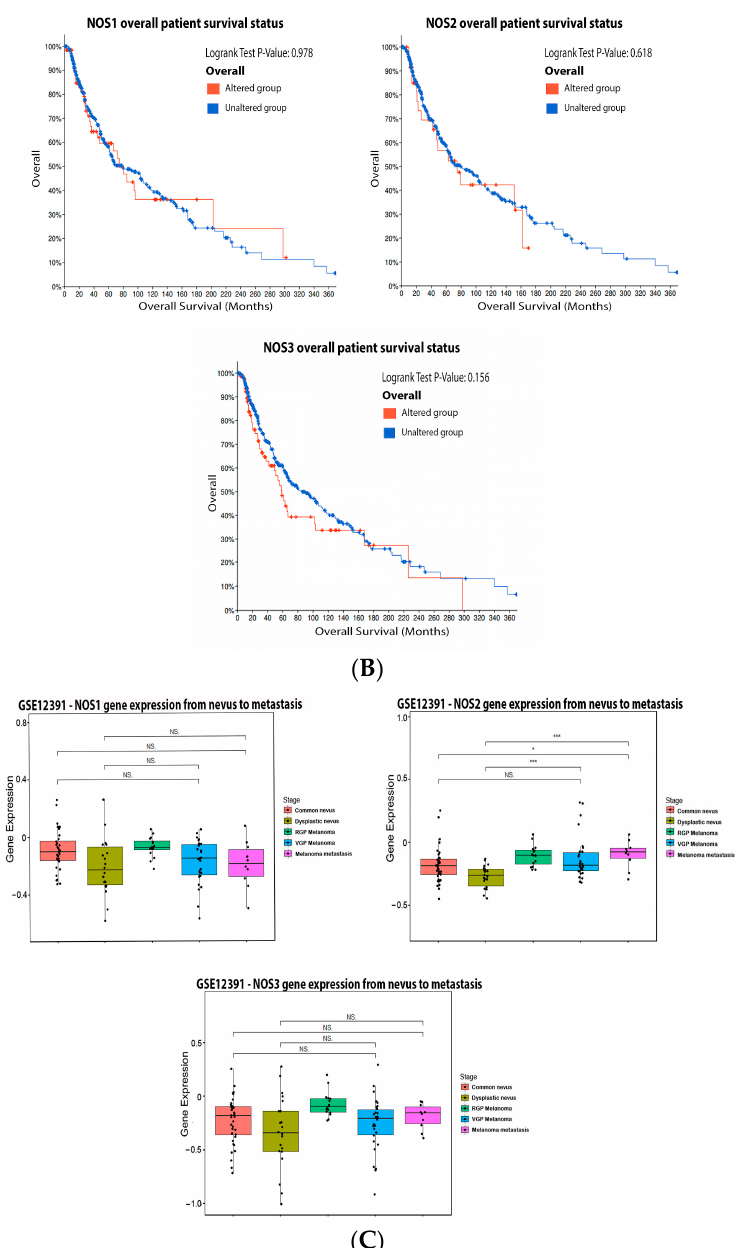
Figure 1. Nitric oxide synthase on melanoma. ( A ) Percentage of patients with altered genes and types of genetic alterations; ( B ) overall patient survival status, and ( C ) expression in melanoma progression. Red boxes represent the common nevus, yellow boxes the dysplastic nevus, green boxes the radial growth phase (RGP) melanoma, blue boxes the vertical growth phase (VGP) melanoma, and purple boxes the metastatic melanoma. The statistical analysis was performed by ANOVA followed by Tukey test, with *** p < 0.001, * p < 0.05 when compared to common or dysplastic nevus. NS: Not